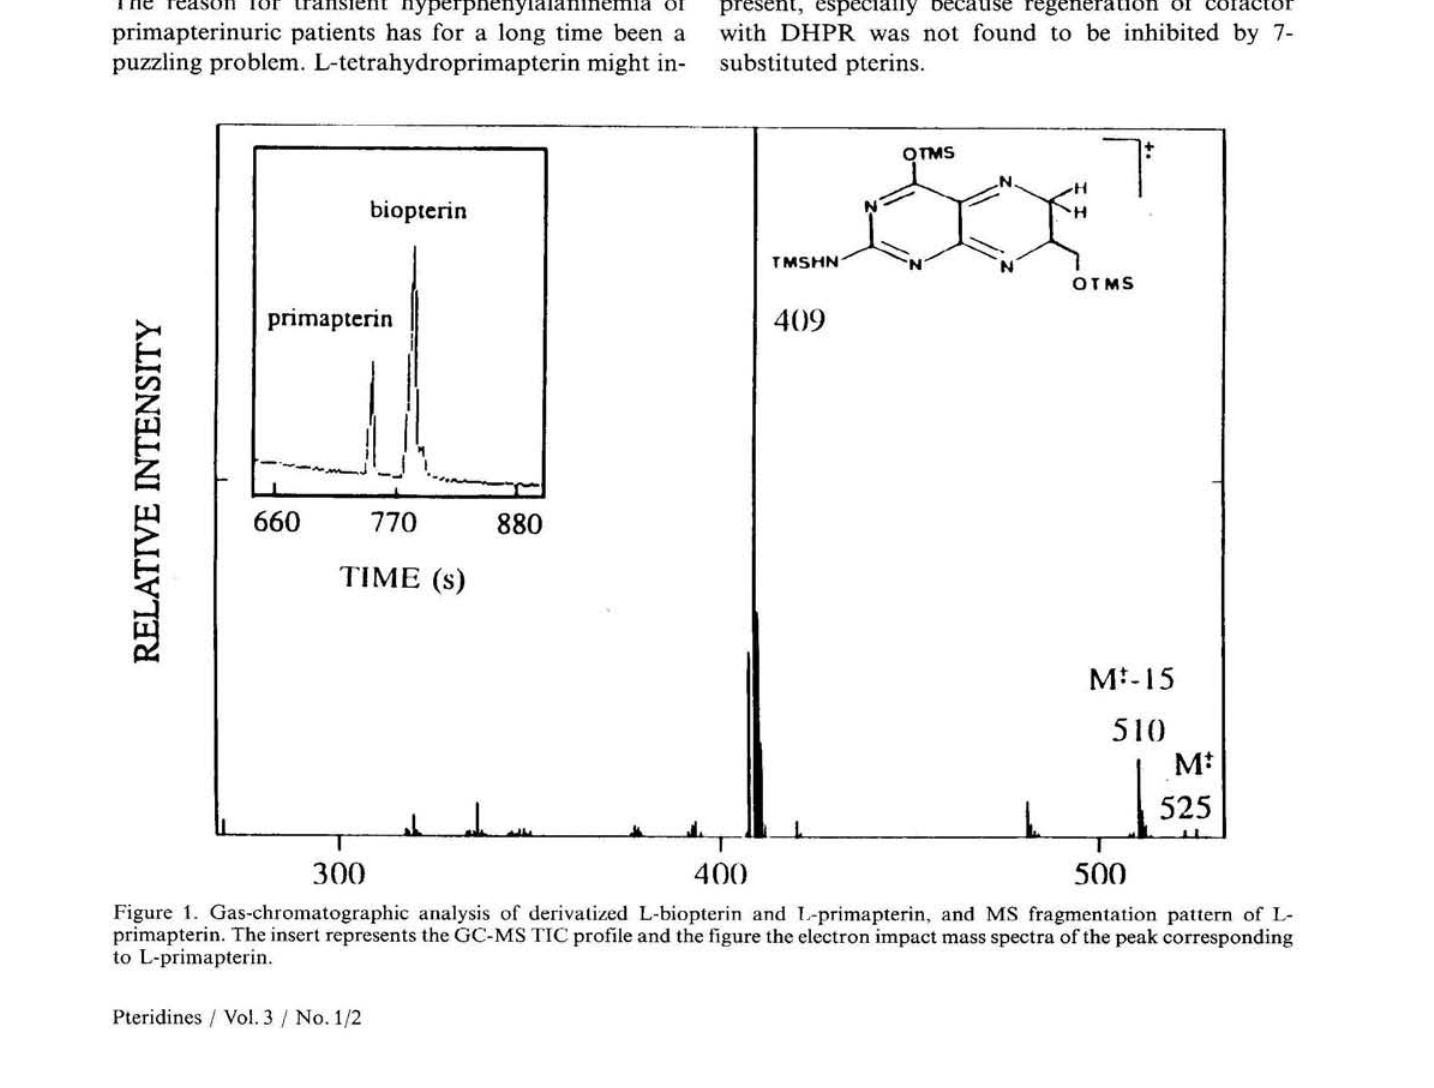
Figure 1. Gas-chromatographic analysis of derivatized L-biopterin and L-primapterin, and MS fragmentation pattern of L- primapterin. The insert represents the GC-MS TIC profile and the figure the electron impact mass spectra of the peak corresponding to